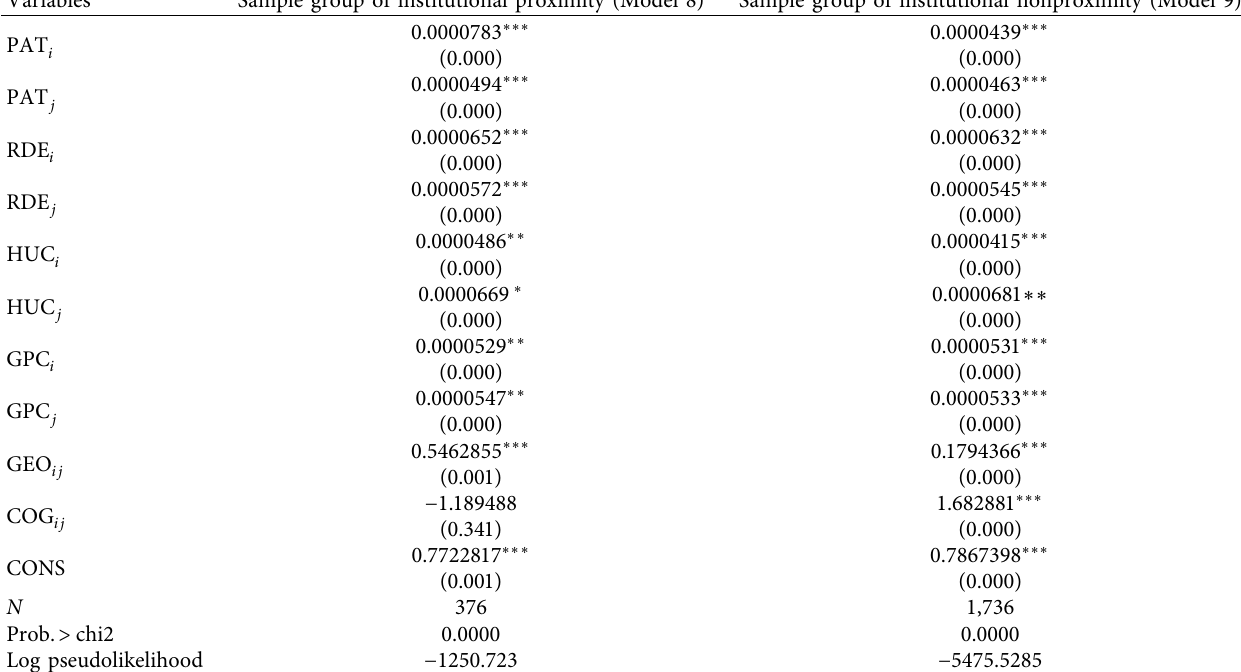
Table 6: Regulatory effect of institutional proximity on geographical and cognitive